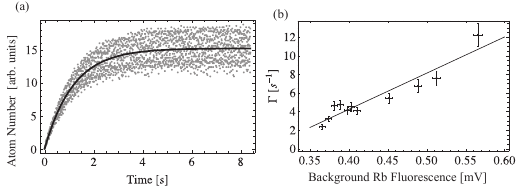
Figure 26. ( a ) Loading curve for the magneto-optical trap (MOT). The data was recorded for a fixed n Rb . A fit to the functional form described in text gives Γ − 1 = 1.17 ± 0.03 s. ( b ) Variation of the collisional rate with background fluorescence, which is proportional to n Rb